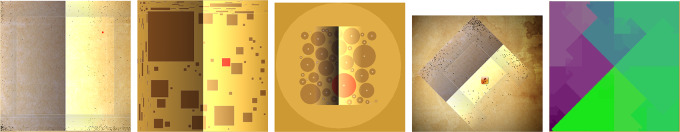
Screenshots of prototype Horstein decoder interfaces.Left-to-right: (a) Simple 2D point based non-linear zooming (b) Nonlinear zooming with rectangular area targets (c) Linear zooming with a randomised circle-packing (d) Diagonal-split interface which only requires left-right decisions (e) An interface using Jigsaw space-filling curves [111] to layout blocks of ordered targets.